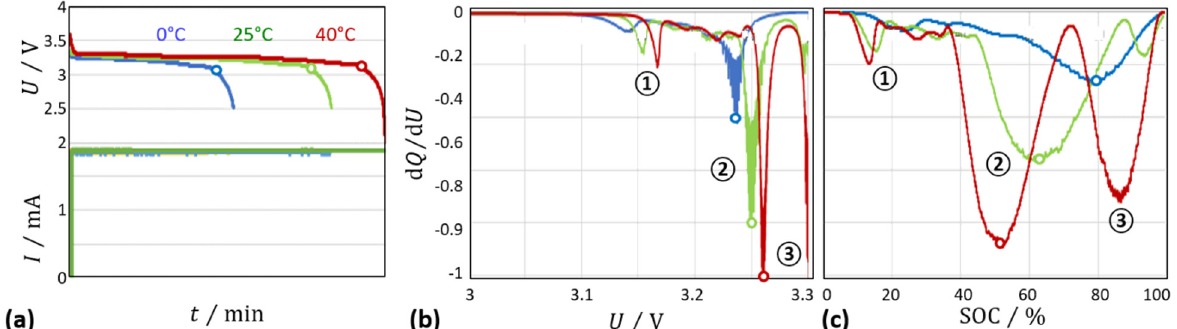
Figure 8. LFP lithium-ion battery (Lithiumwerks) at different temperatures: ( a ) constant current discharge, ( b ) relative change of differential capacity dQ/dU against voltage, ( c ) against state-of-charge. ① almost empty, ② half-full, ③ almost full.